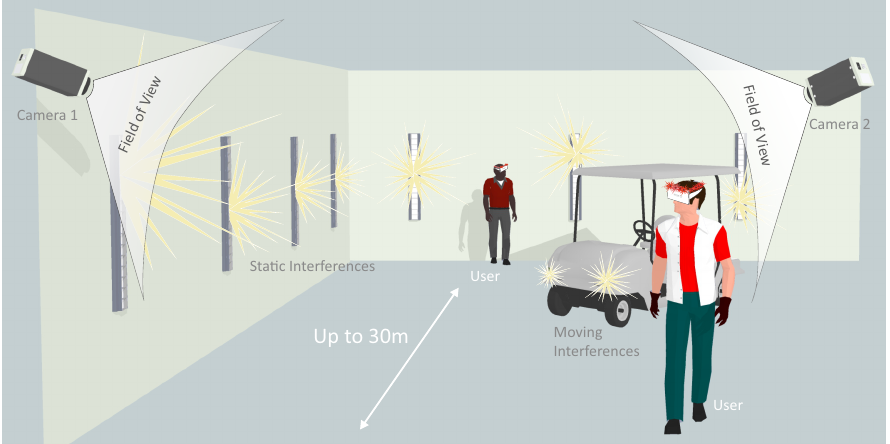
Figure 19. Wide area user tracking in a virtual reality